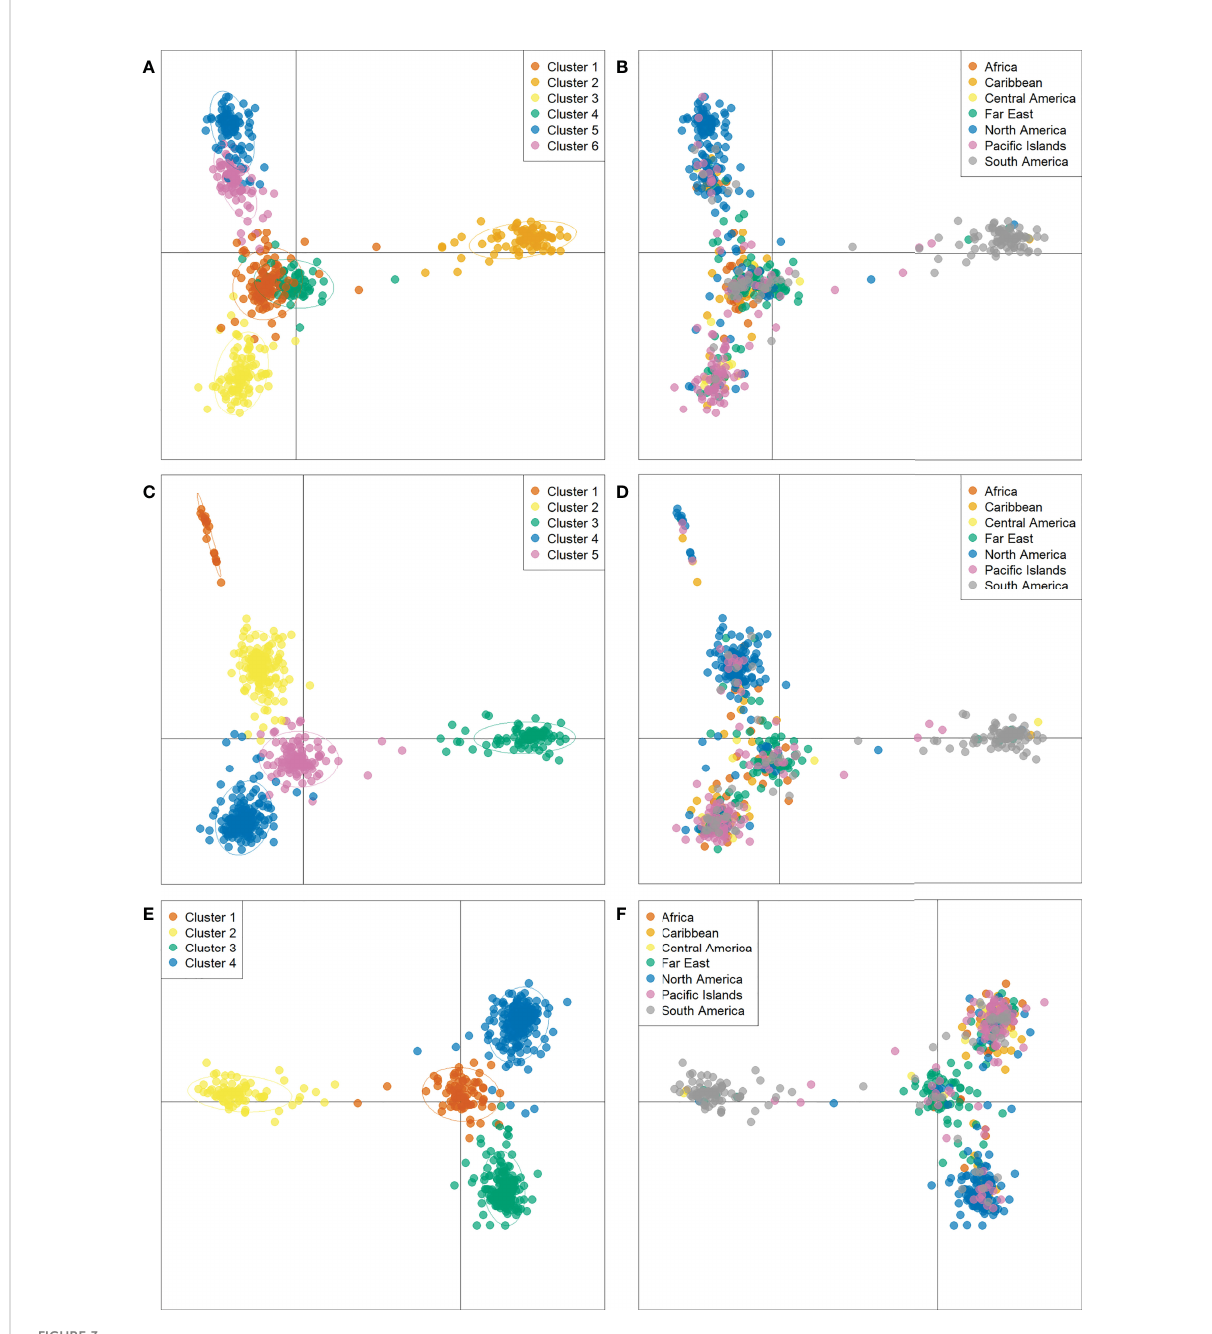
FIGURE 3 Discriminant analysis of principal components (DAPC) of 604 sweetpotato ( Ipomoea batatas ) accessions scatterplots representing K=6 (A, B) , K=5 (C, D) , and K=4 (E, F) labeled by cluster assignment and country of origin